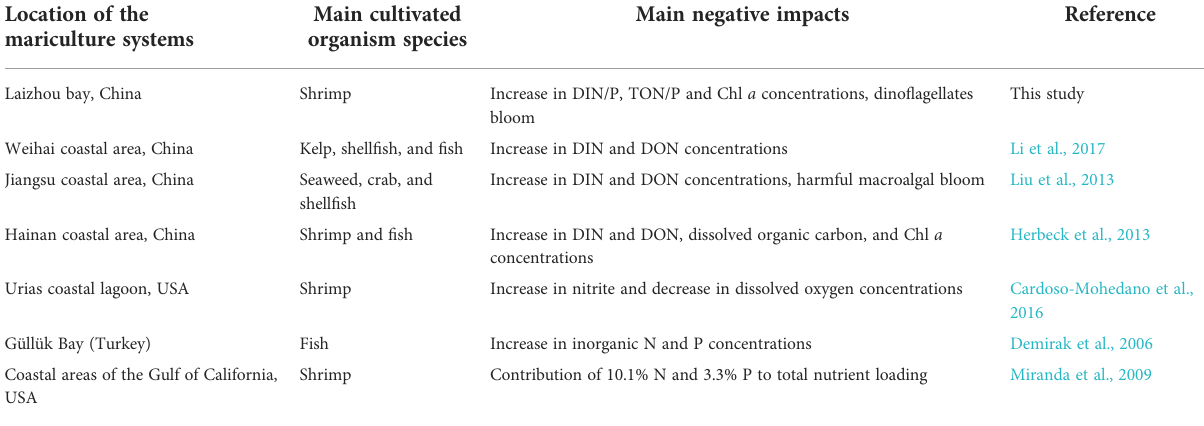
TABLE 1 Main negative impacts caused by intensive mariculture systems in the Laizhou bay compared with other coastal